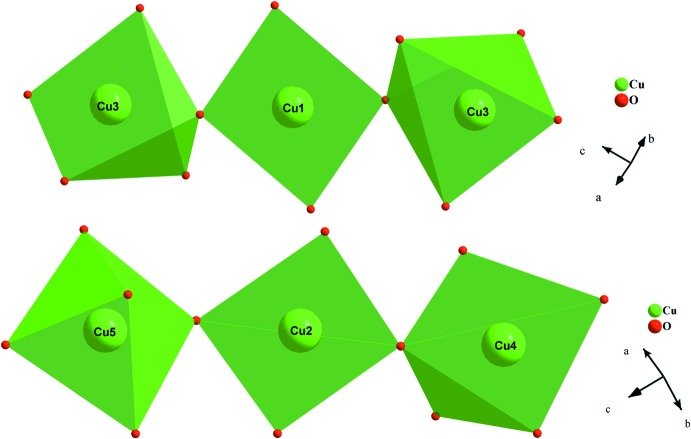
Vertex-sharing [CuO5] and CuO4 polyhedra forming two [Cu3O12] trimers.